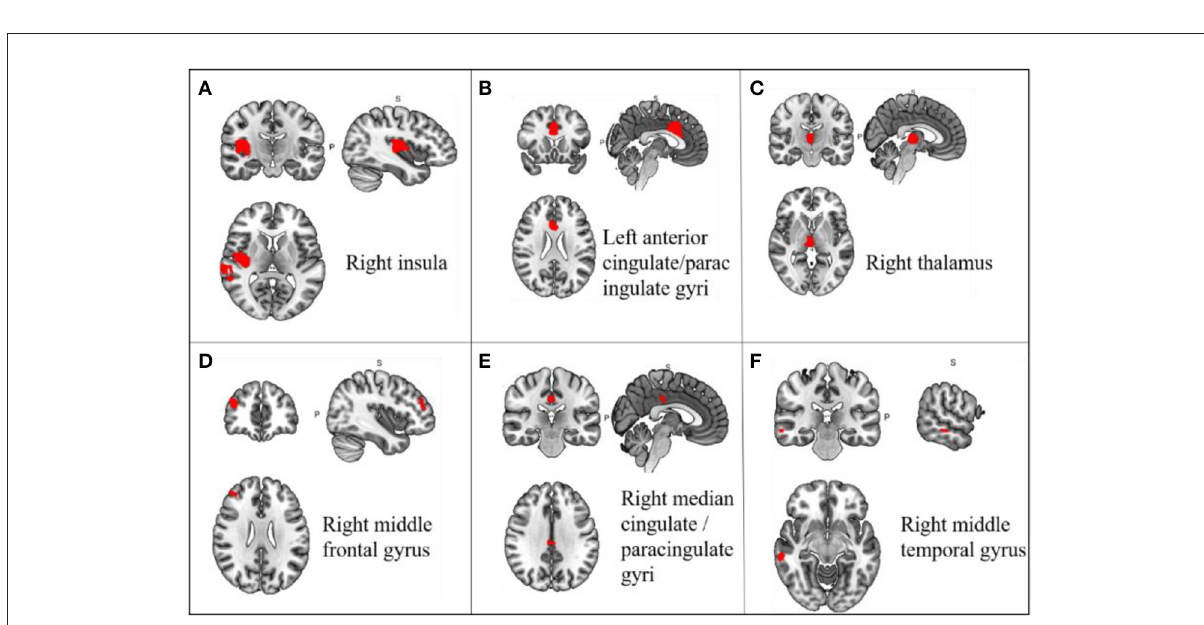
FIGURE3 Changes in gray matter regions PRE and POST acupuncture treatment in MCI patients. (A) Right insula; (B) Left anterior cingulate/paracingulate gyri; (C) Right thalamus; (D) Right middle frontal gyrus; (E) Right median cingulate/paracingulate gyri; (F) Right middle temporal gyrus. Important clusters are presented with MRIcron